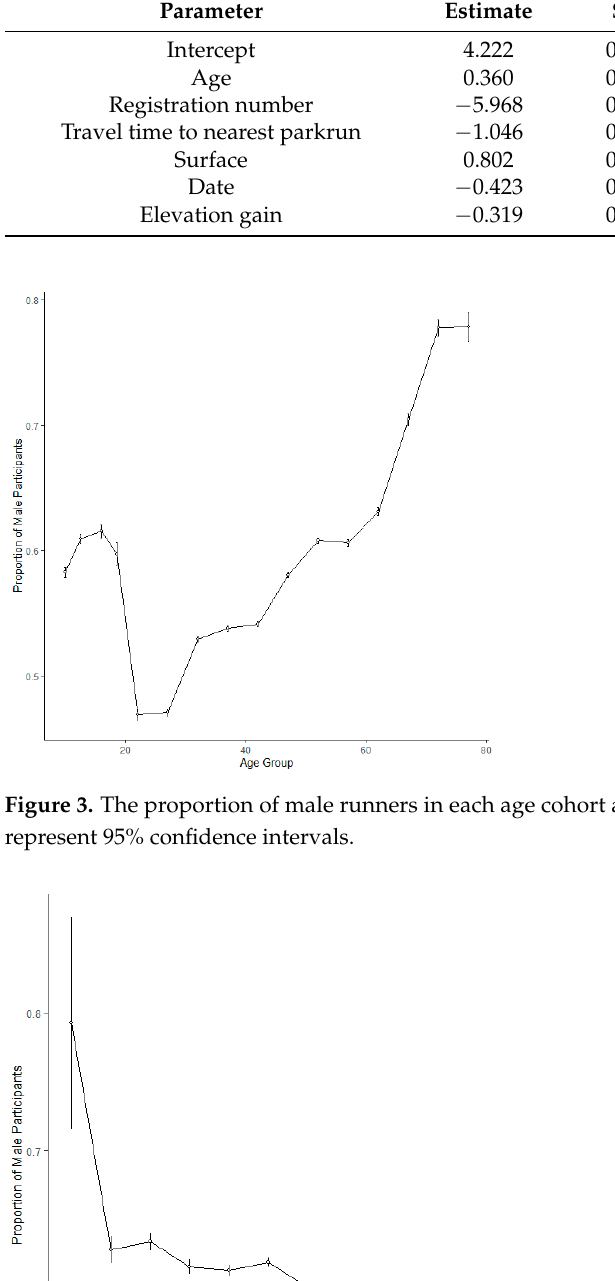
Figure 5. The proportion of male runners by travelling time in minutes to the next nearest parkrun event. Error bars represent 95% confidence intervals. 3.5. Age of Participants at Parkrun Events in Scotland A linear mixed model of the age of participants at Scottish parkrun events (Table 4) revealed that the average age is increasing over time, yet the age of new registrants is decreasing. Table 4. A linear mixed model of the age of participants at parkrun events in Scotland. Event venue was included as a random effect. Parameter